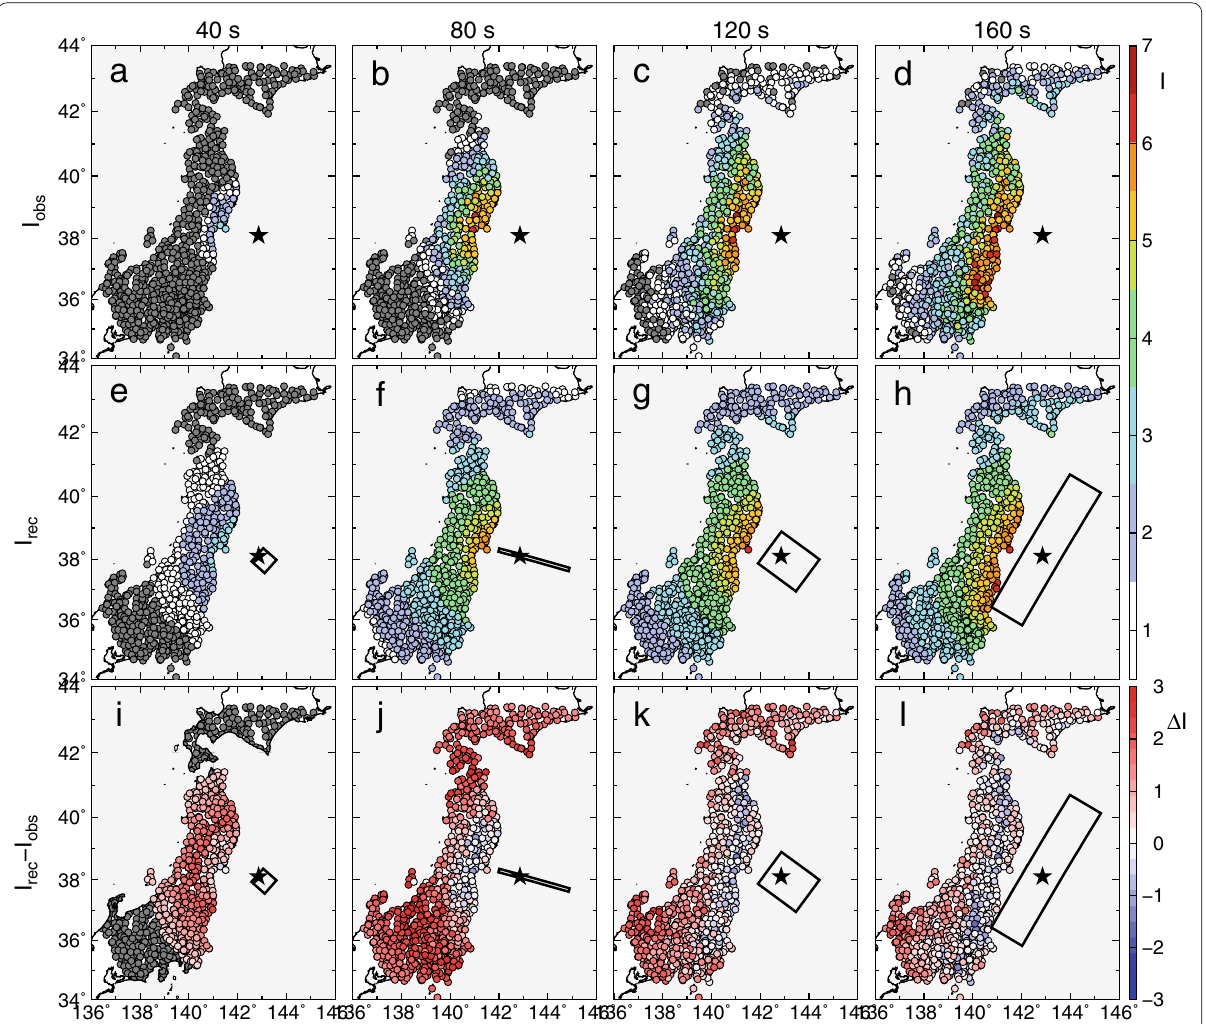
Fig. 7 Snapshots of the seismic intensities of the RS model for the 2011 Tohoku earthquake. Black stars and thick rectangles show the epicenters and the source models, respectively. a – d Observed intensities. e – h Estimated intensities. i – l Difference between the observed and estimated